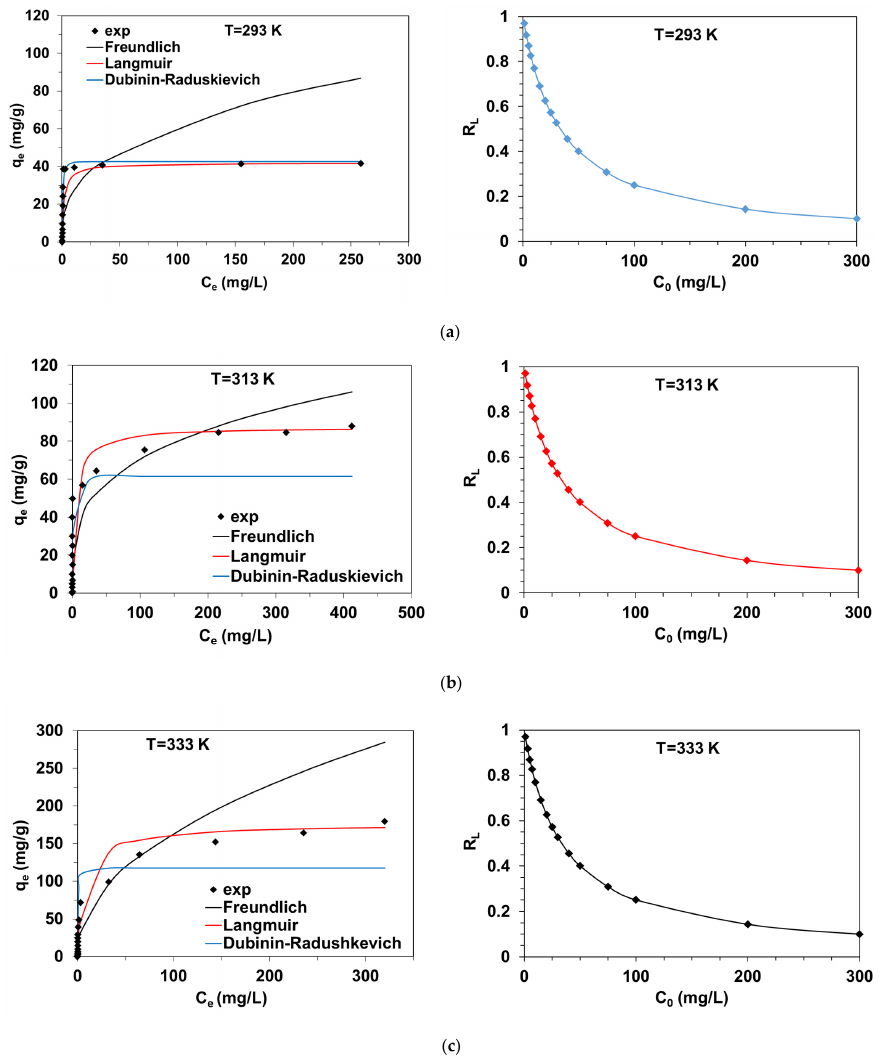
Figure 2. Comparison of the experimental adsorption data of BR46 on C/SiO 2 with fitting curves corresponding to the Freundlich, Langmuir and Dubinin–Radushkevich as well as changes of the separation factor ( R L ) at ( a ) 293 K, ( b ) 313 K and ( c ) 333 K. Molecules 2022 , 27 , x. https://doi.org/10.3390/xxxxx